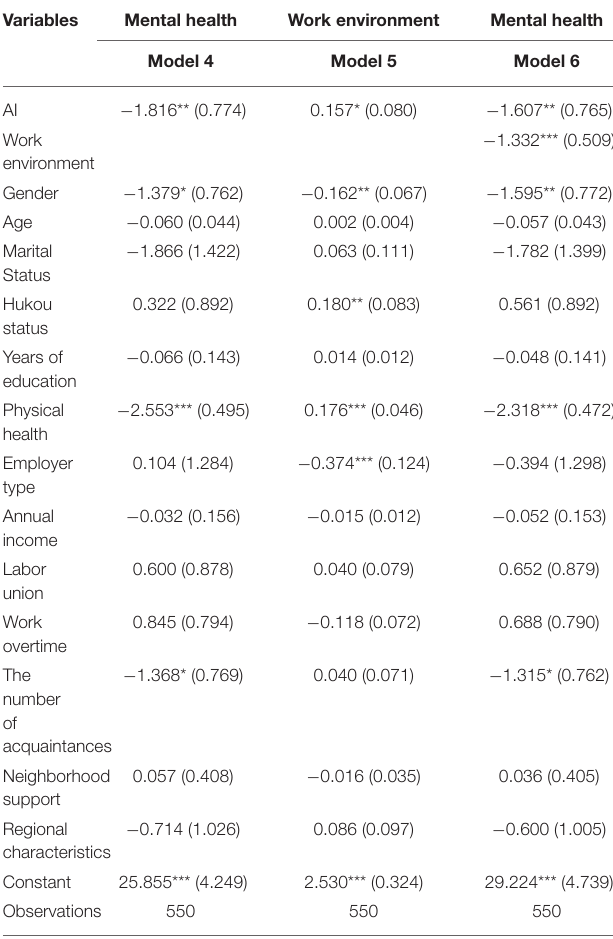
TABLE 3 | The impact of AI on the mental health of manufacturing workers: overall and mediating